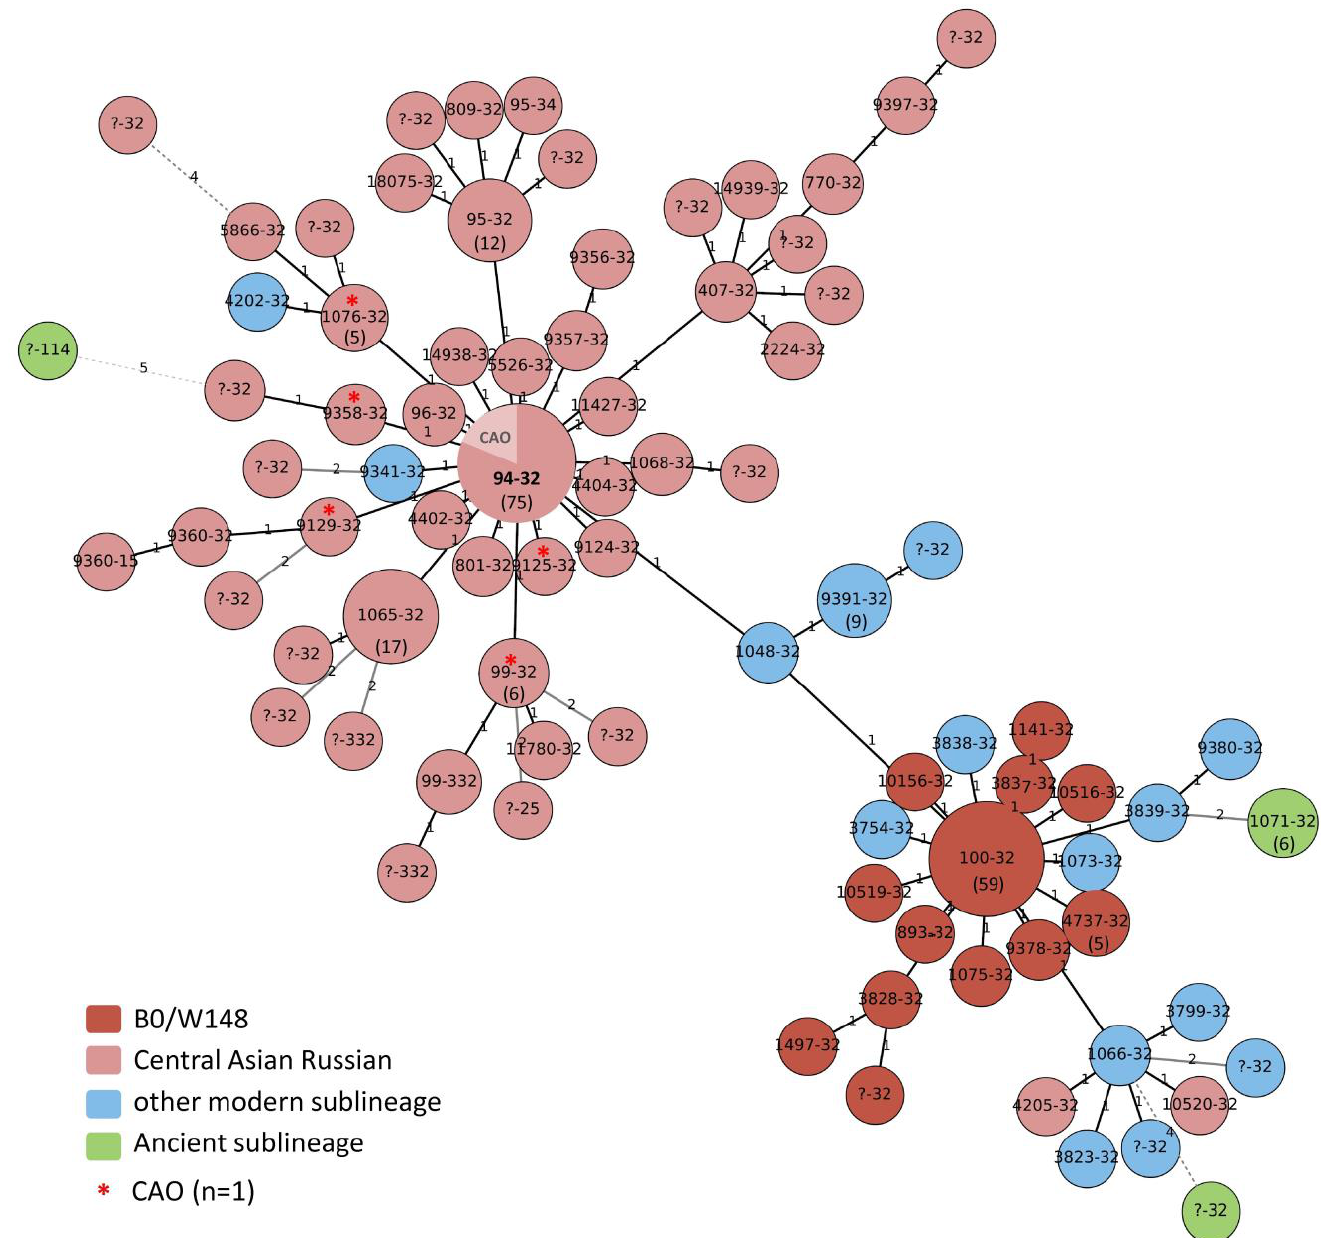
Figure 1. Minimum spanning tree of 24-MIRU-VNTR profiles of 286 strains of M. tuberculosis Beijing genotype strains. Node sizes only roughly correlate with the sample size. The number of isolates in the largest types ( n > 4) is shown inside the circles in brackets. Designations of MIRU-VNTR profiles are given according to the MLVA Mtbc15-9 nomenclature. Lines between nodes show changes related to 1 locus variation (solid bold lines), 2 loci variation (solid thin lines), and >2 loci variation (dashed lines). Numbers on the lines show the number of variant alleles.